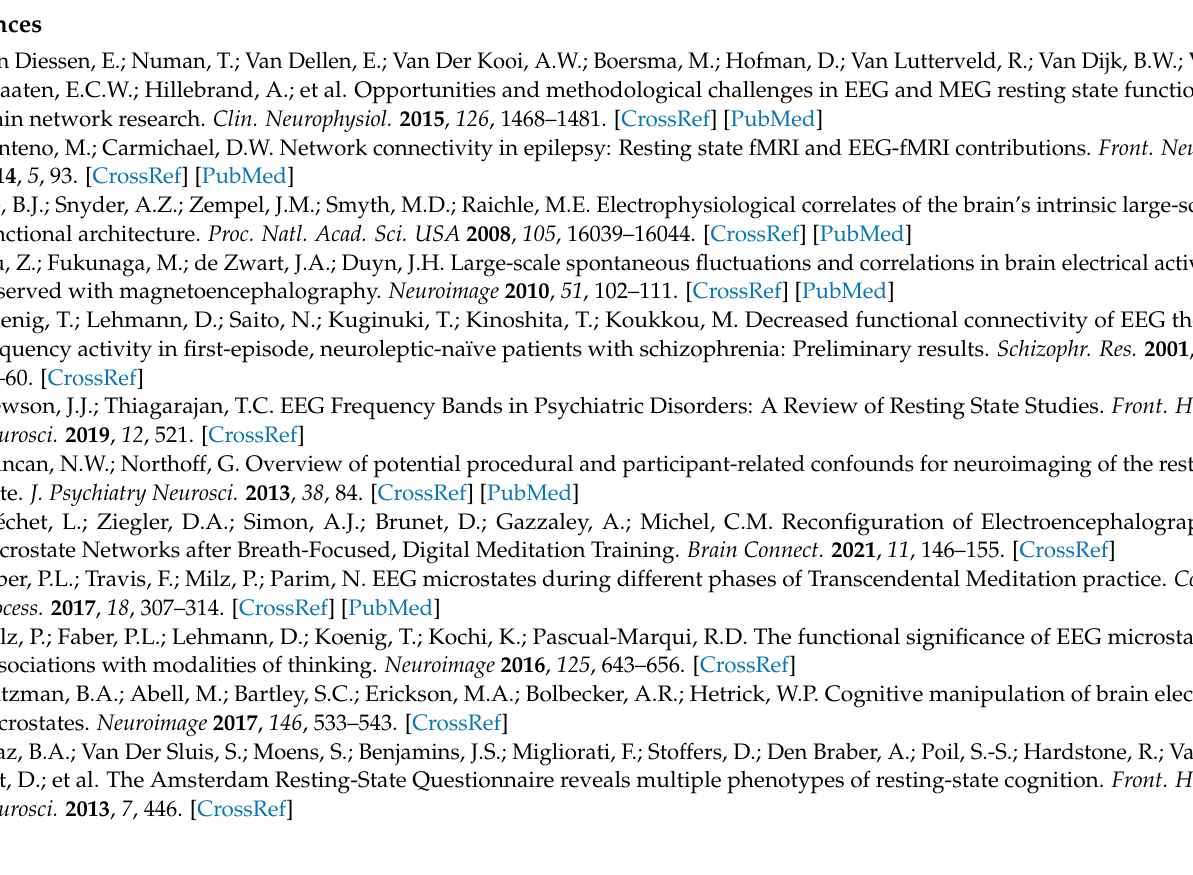
Table S2: The results of two-way ANOVA for the occurrence parameter; Table S3: The results of two-way ANOVA for the duration parameter; Table S4: The results of two-way ANOVA for the GFP parameter; Table S5: Bayesian Pearson Correlation coefficients between age and ARSQ dimensions; Table S6: Bayesian Pearson correlation coefficients between age and microstate parameters. Figure S1: Plot of spatial correlations between microstate C, when k = 4 (Top), and microstates C and F, when k = 7 (Middle and